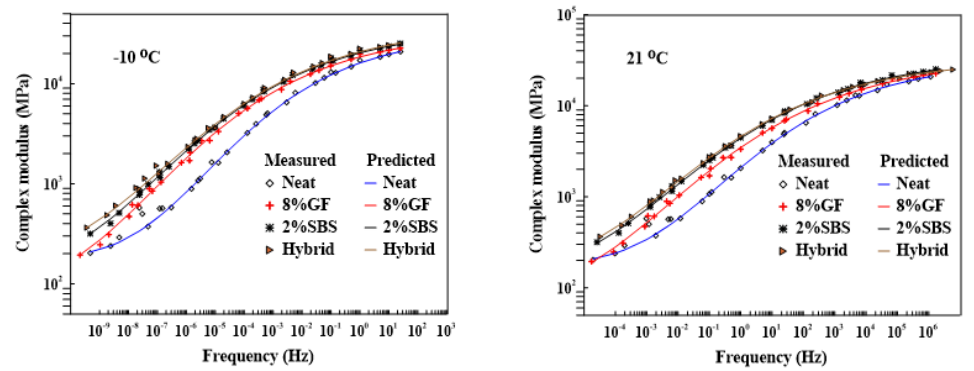
Figure 13. Dynamic or complex modulus master curves at − 10 ◦ C and 21 ◦